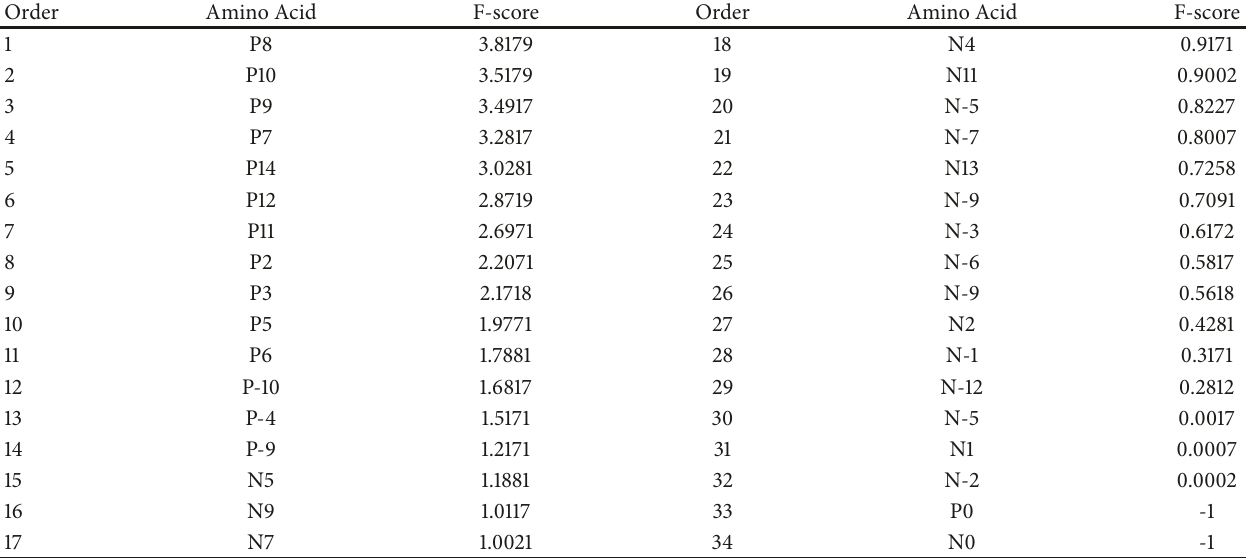
Table 3: The BPB features ranked by F-score